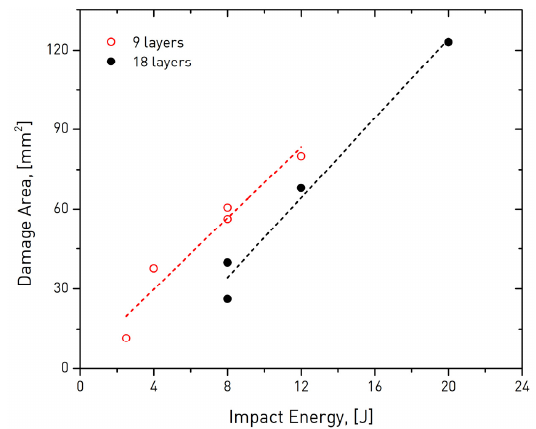
Figure 10. Area of damage after impact of thin (9 layer) and thick (18 layer) aircraft-grade composite specimens as a function of impact energy.